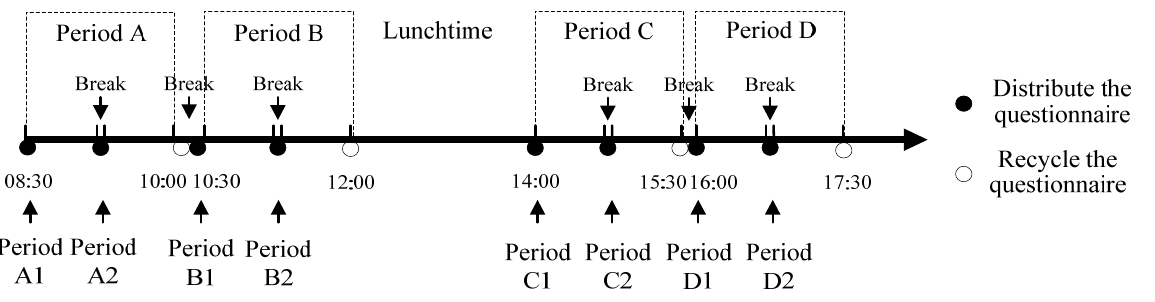
Figure 5. Timeline of the questionnaire survey. Table 2. Thermal perception